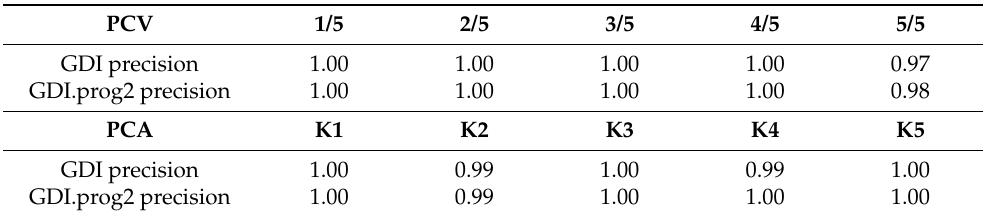
Table 3. Attribute classification accuracy comparison for the two fixed-precision CD-CAT implemen- tations.